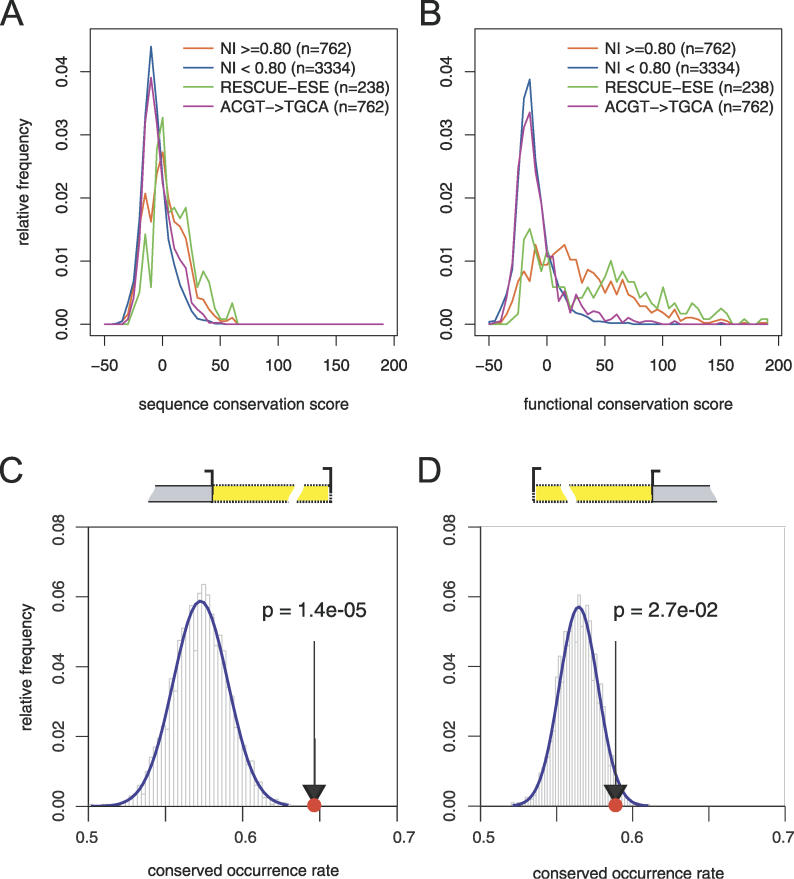
Conservation of Predicted ESE and ESS Hexamers(A and B) Phylogenetic conservation of NI-predicted ESEs was measured across human, mouse, rat, and dog genomes. Conservation of predicted ESE hexamers (orange curve, NI score ≥ 0.8) was compared to the conservation of all other hexamers (blue curve, NI score < 0.8), RESCUE-ESE hexamers (green line), or a control set of equal size (purple curve, randomized by nucleotide substitution as described in text) in a histogram of conservation scores, either measuring conservation of sequence (A) or conservation of function (B) as predicted by NI.(C and D) Conservation of NI-predicted ESSs was estimated using the COR measure as described in the Materials and Methods. The histograms represent COR values obtained for control sets of hexamers, and the red circle indicates the value for predicted ESS hexamers located between alternative 5′ splice sites (C) or between alternative 3′ splice sites (D). The analyzed exonic region between alternative splice sites is illustrated by a yellow box, with splice sites represented by brackets pointing to the left and right for 5′ and 3′ splice sites, respectively.